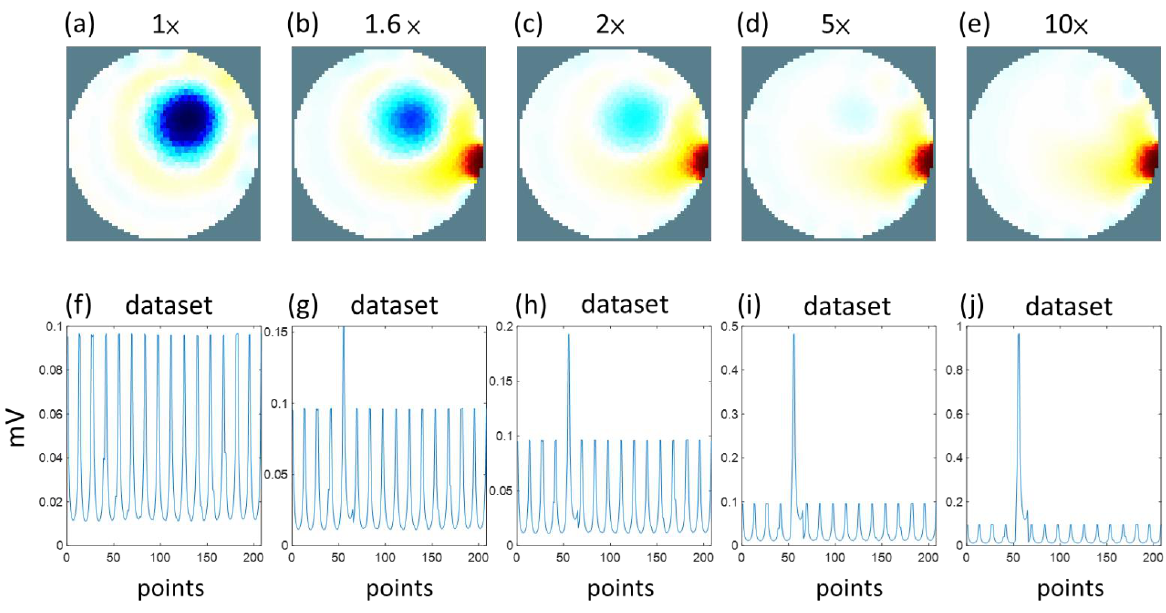
Figure 3. Simulated EIT images and the 208-voltage measurement dataset. ( a ) EIT image without spike value. ( b ) EIT image with spike value 1.6×. ( c ) EIT image with spike value 2×. ( d ) EIT image with spike value 5×. ( e ) EIT image with spike value 10×. ( f ) Measurement data with 16 well- contacted electrodes. ( g ) Measurement data with spike value 1.6×. ( h ) Measurement data with spike value 2×. ( i ) Measurement data with spike value 5×. ( j ) Measurement data with spike value 10×.